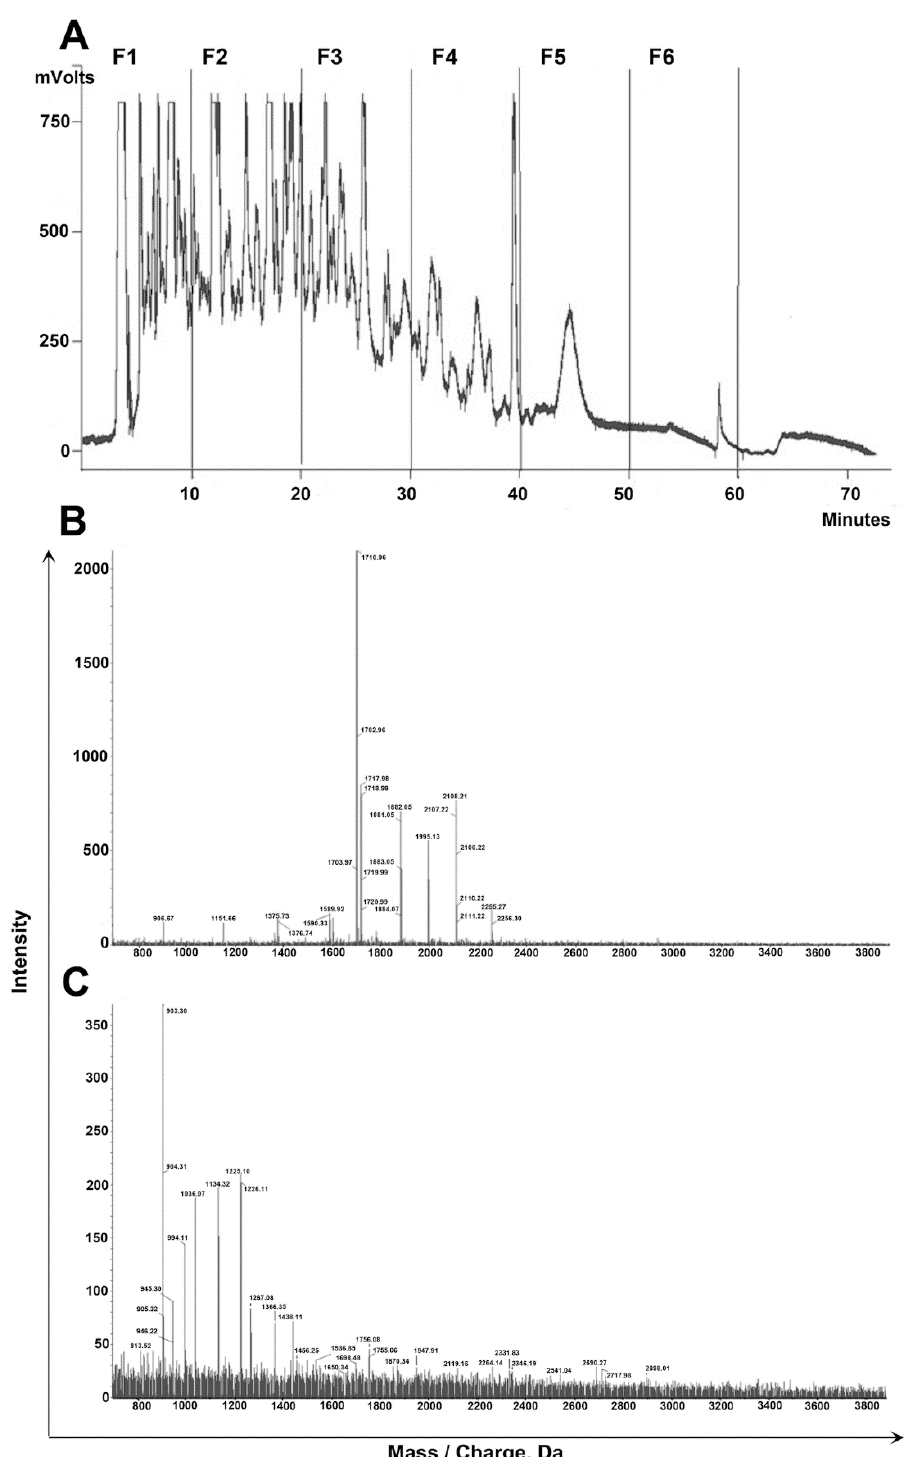
Figure 3. ( A ) Identification of 6 peptide fractions (F1-F6) by RP-HPLC from skim milk fermented with a combination of L. helveticus 881315 and Flavourzyme ® . Molecular mass for ( B ) F1 and ( C ) F6 are shown.